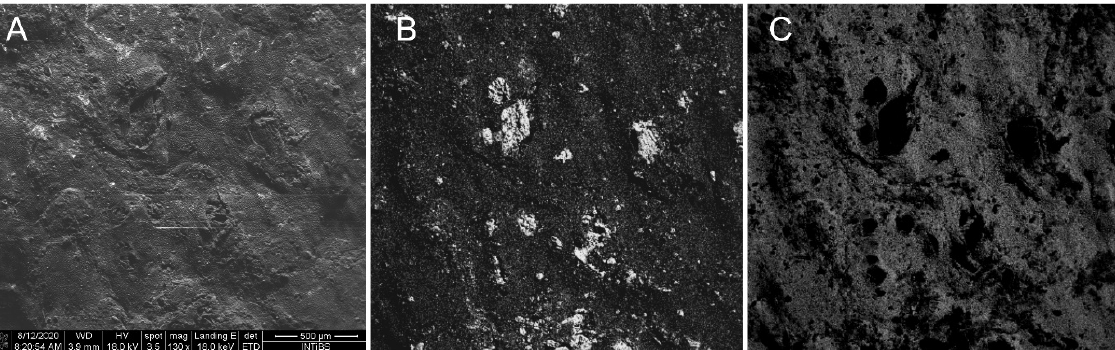
Figure 7. Microstructure SEM—magnification 8000× ( A ) and 150× ( B ) of ACC cloth (part of FSM) and elemental analysis (EDS) of carbon distribution ( C ) .